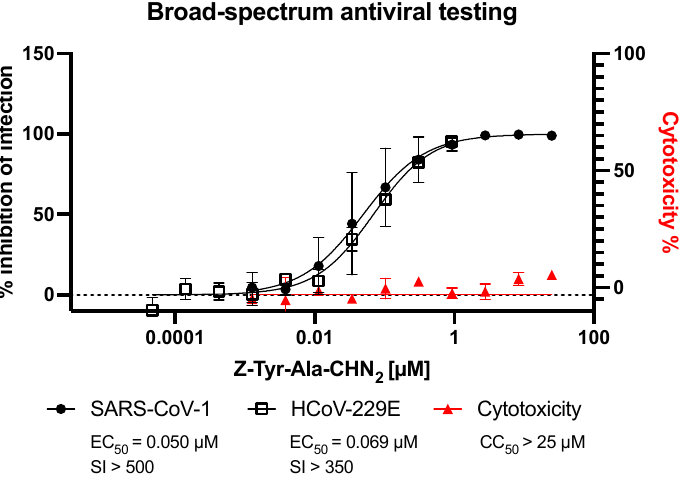
Figure 3. Antiviral activity of Z-Tyr-Ala-CHN 2 against SARS-CoV-1 (black, full circles) in A549-hACE2 and against HCoV-229E (black, empty squares) in HeLa-hACE2. Infection of SARS-CoV-1 was detected using an anti-spike antibody, whereas infection against HCoV-229E was detected using an anti-dsRNA antibody. The mean ± SD values are shown from two to three independent experiments. Cytotoxicity determined in uninfected A549-hACE2 using ATPlite (red, full triangles) represents the mean ± SD of two independent experiments. HCoV-229E, human coronavirus 229E; SD, standard deviation; SI, selectivity index.